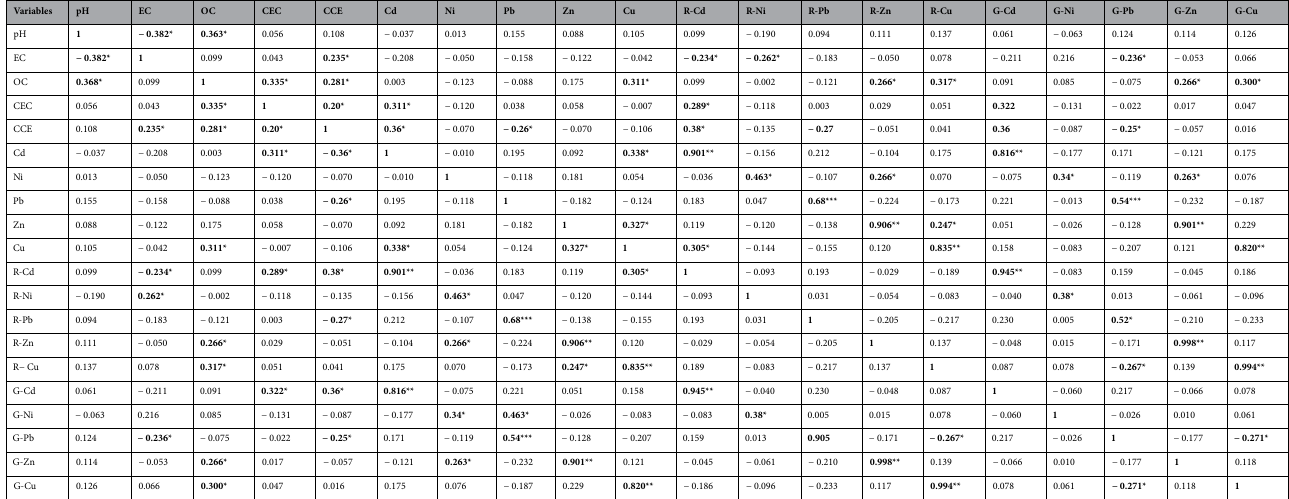
Table 5. Pearson correlation coefficients between heavy metals concentration of (in soil and corn root and grain) with selected soil properties. *, **, and *** indicate the significance of correlation at 0.05, 0.01, and 0.001 confidence intervals,